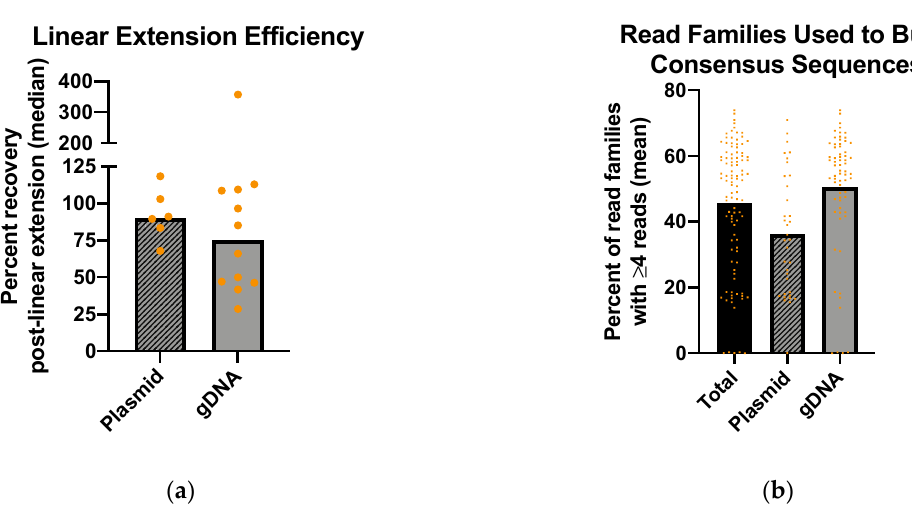
Figure 3. Amplification efficiency of the MDS pipeline. ( a ) Linear extension efficiency. The efficiency of linear extension was determined by dividing the number of tagged EGFP molecules following linear amplification by the total number of starting EGFP molecules, as measured using ddPCR. The median linear extension efficiency was 90.2% in plasmid samples and 75.5% in gDNA samples ( p = 0.002). Replicates are marked as individual points; ( b ) Read families used to build consensus sequences. The efficiency of exponential amplification was evaluated by determining the percent of read families with 4 or more reads, which represented read families which would be used to generate consensus sequences. In total, an average of 45.7% of read families contained 4 or more reads (plasmid samples, 36.3%; gDNA samples, 50.6%).